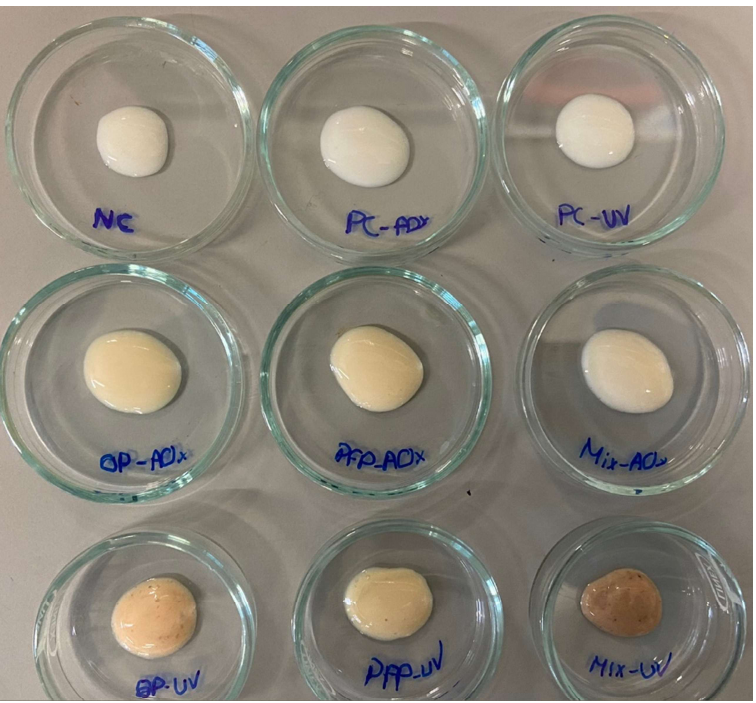
Figure 4. Produced moisturizing creams. NC: negative control; PC-AOx: positive antioxidant control; OP-AOx: onion peel extract antioxidant sample; PFP-AOx: passion fruit peel extract antioxidant sample; Mix-AOx: mixture of antioxidant control and OP and PFP extract; PC-UV: positive UV filter control; OP-UV: onion peel extract UV filter sample; PFP-UV: passion fruit peel extract UV filter sample; Mix-UV: mixture of UV filter control and OP and PFP extract.